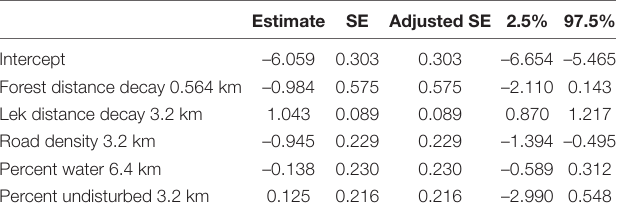
TABLE 7 | Full model averaged standardized coefficient estimates and profile likelihood 95% confidence intervals for nest-site resource selection function